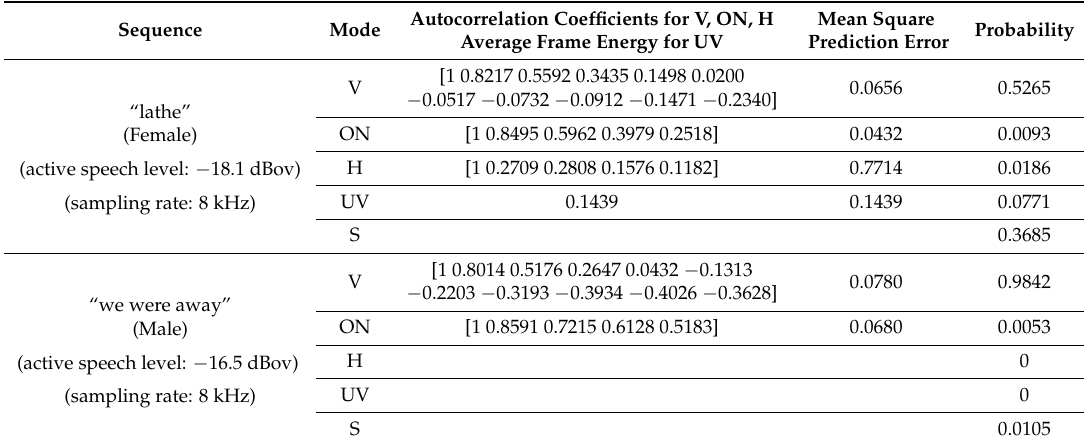
Table 4. Composite source models for narrowband speech sentences [6]. V, voiced; UV, unvoiced; ON, onset; H, hangover; S, silence.